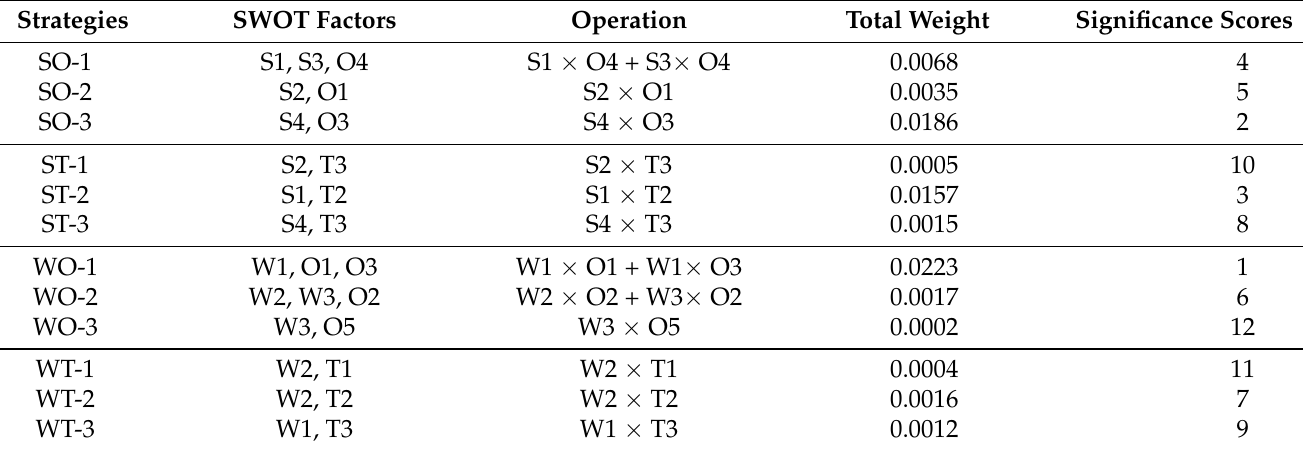
Table 14. Calculation of the significance scores of the TOWS